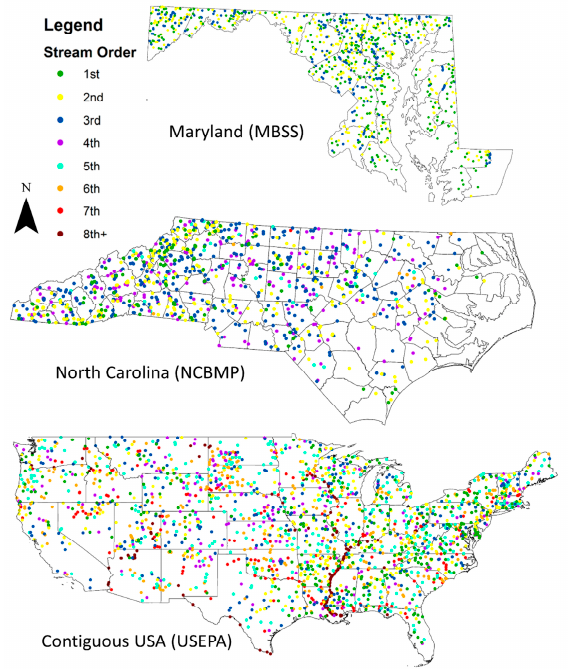
Figure 1. Map of macroinvertebrate and fish community collection sites from Maryland Biological Stream Survey (MBSS, upper right, n = 952 sites) and North Carolina Basinwide Monitoring Program (NCBMP, lower right, n = 1222 sites) and the contiguous USA (USEPA, center, n = 2123 sites). Colors indicate Strahler stream order from 1st order to 8th order. Map not to scale.